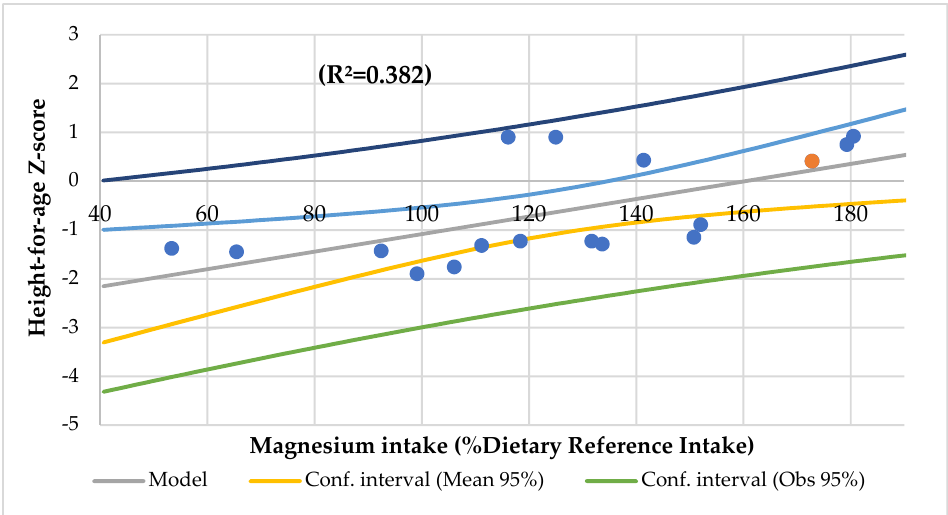
Figure 3. Regression height-for-age Z-score by magnesium intake (%Dietary Reference Intake).